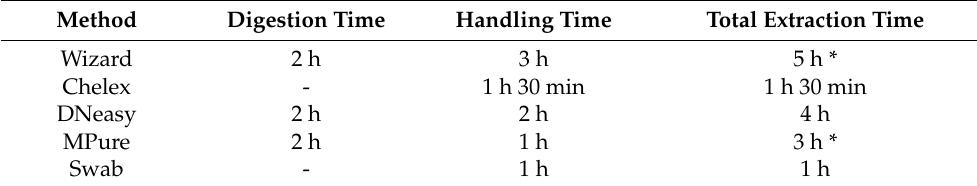
Table 1. Digestion time, handling time and total extraction time of the tested